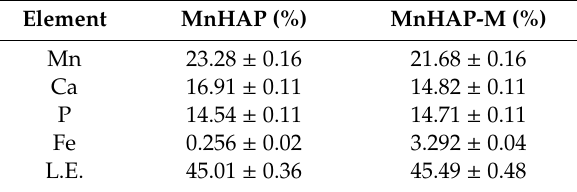
Table 2. Elemental analysis of the MnHAP and MnHAP-M samples. L.E.—light elements (not detectable by XRF).